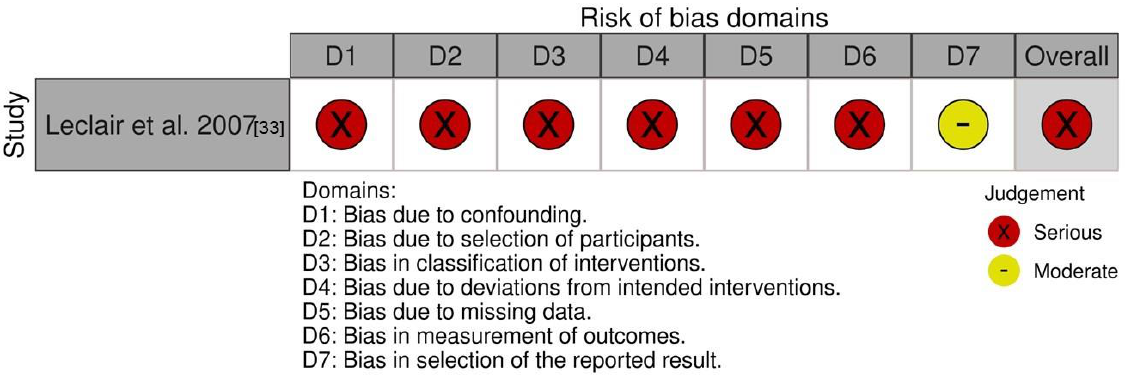
Figure 3. Risk of bias (RoB) of the included vulvodynia study assessed with the ROBINS-I.